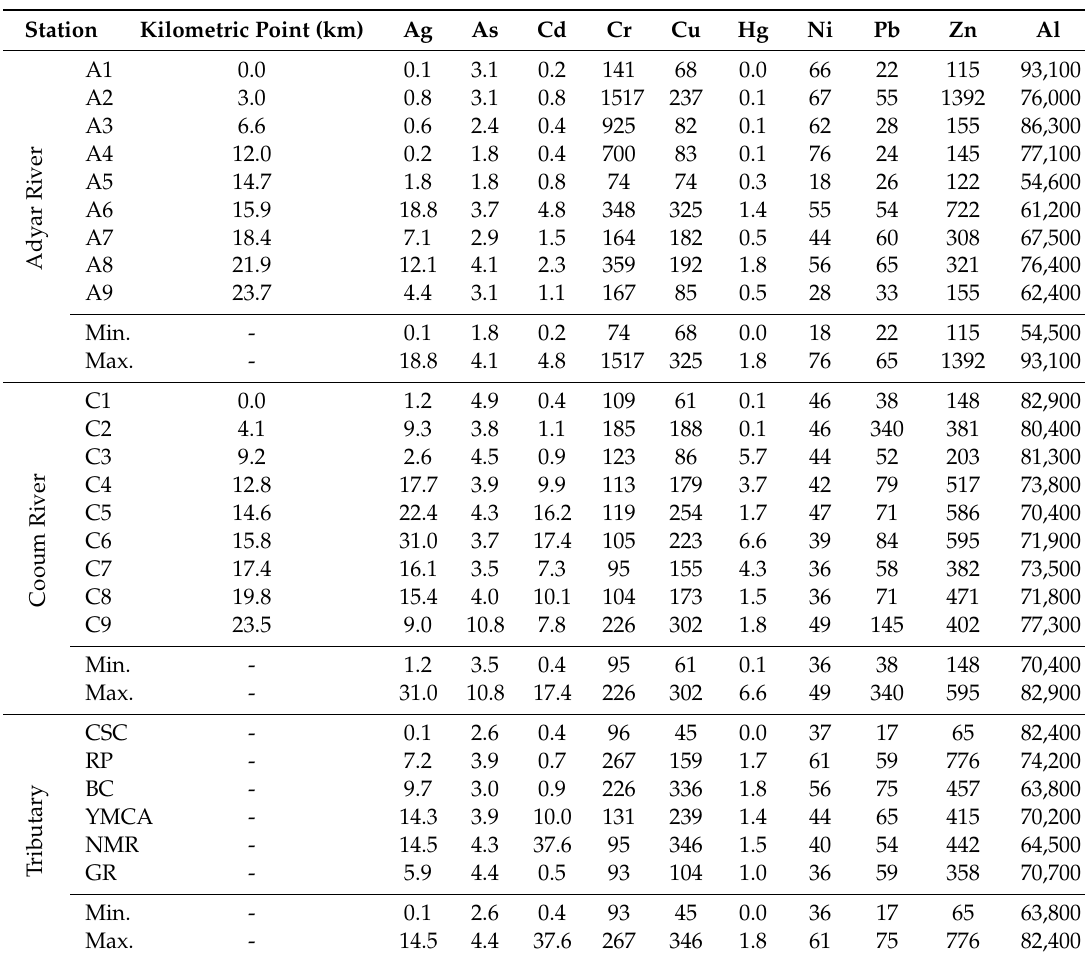
Table 1. Trace element and aluminium concentrations (mg / kg) in the Adyar river basin (A stations) and Cooum river basin (C stations) from upstream to downstream, with KP 0.0 being the most upstream station sampled, and their associated drains (see Figure 1 for